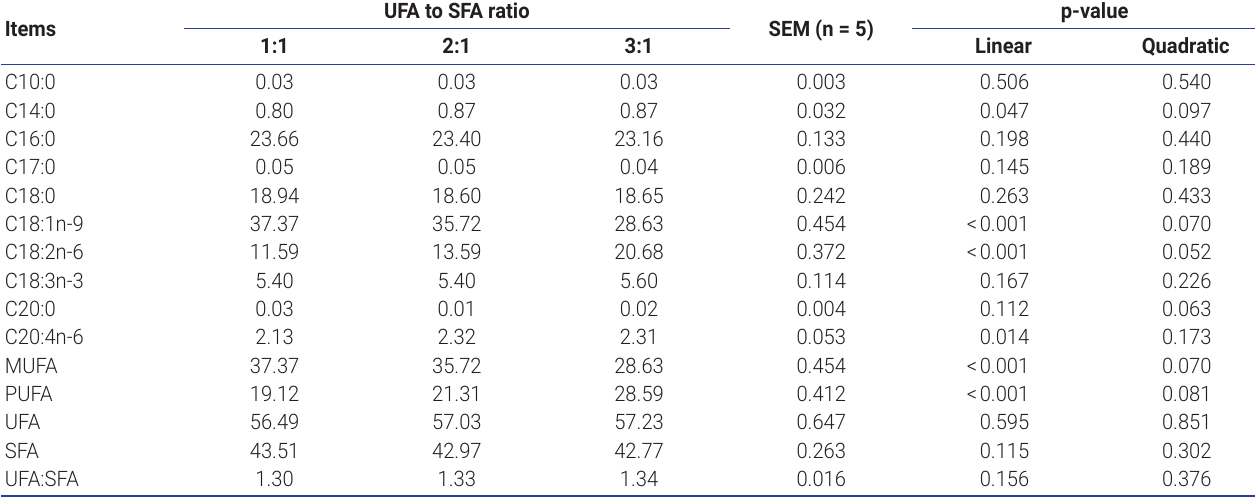
UFA to SFA ratio